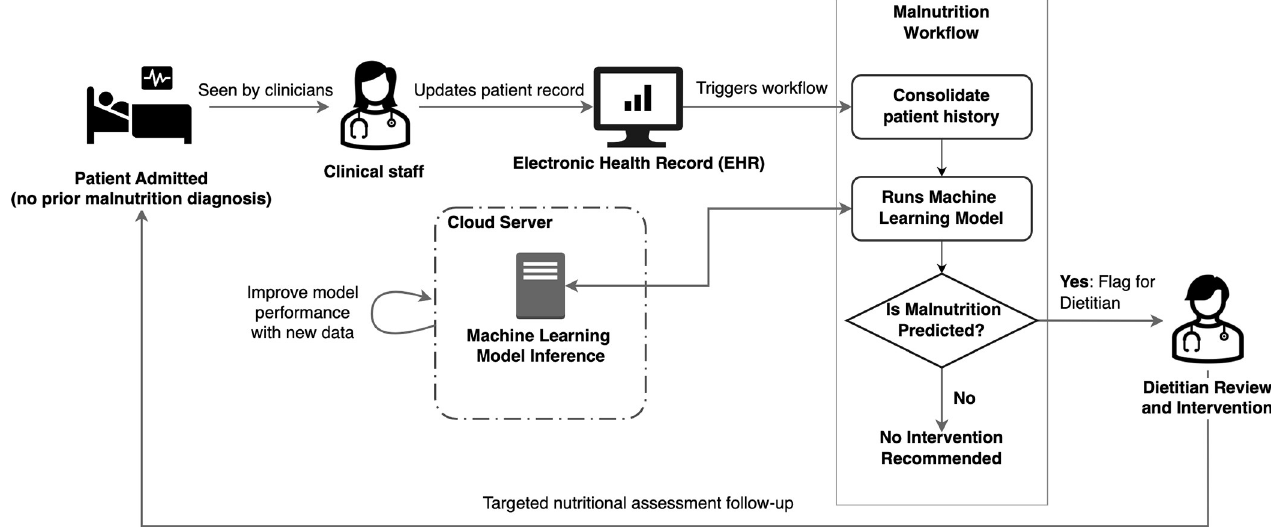
Fig 4. Proposed clinical implementation strategy to identify patients at risk for malnutrition and trigger dietitian referral or consultation.